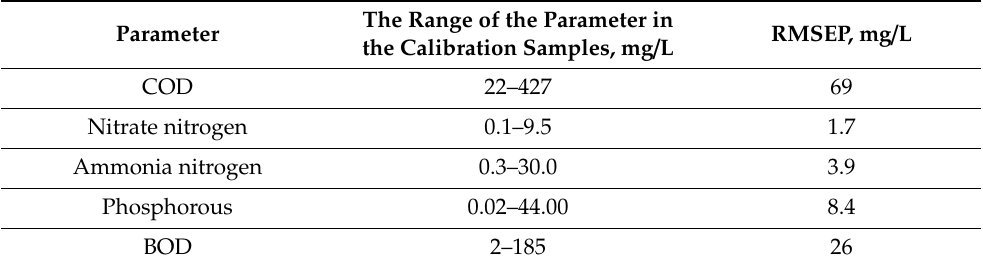
Table 4. The values of root mean square error of prediction (RMSEP) for water parameter’s evaluation using the multisensor